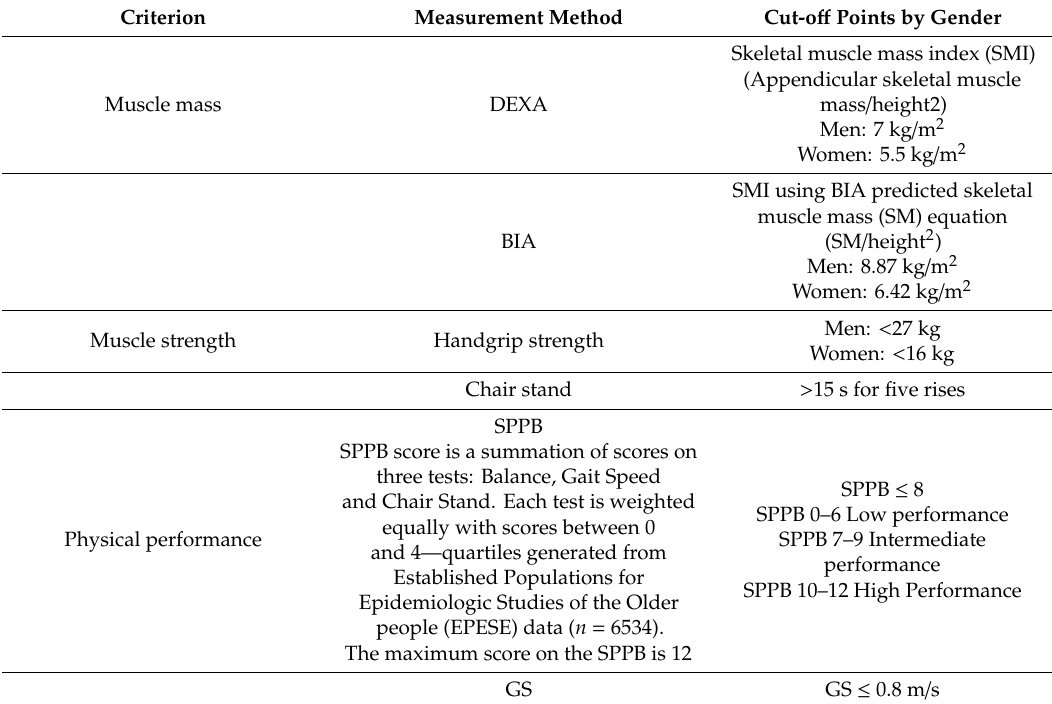
Table 1. Sarcopenia: measurable variables and cut-o ff points